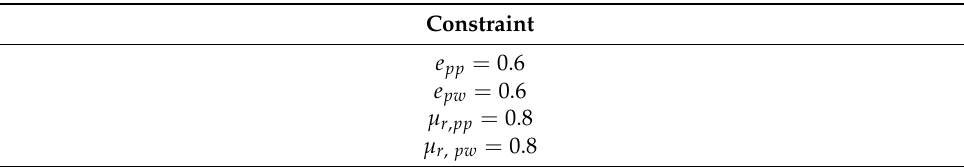
Table 4. Constraints introduced to reduce the number of possible